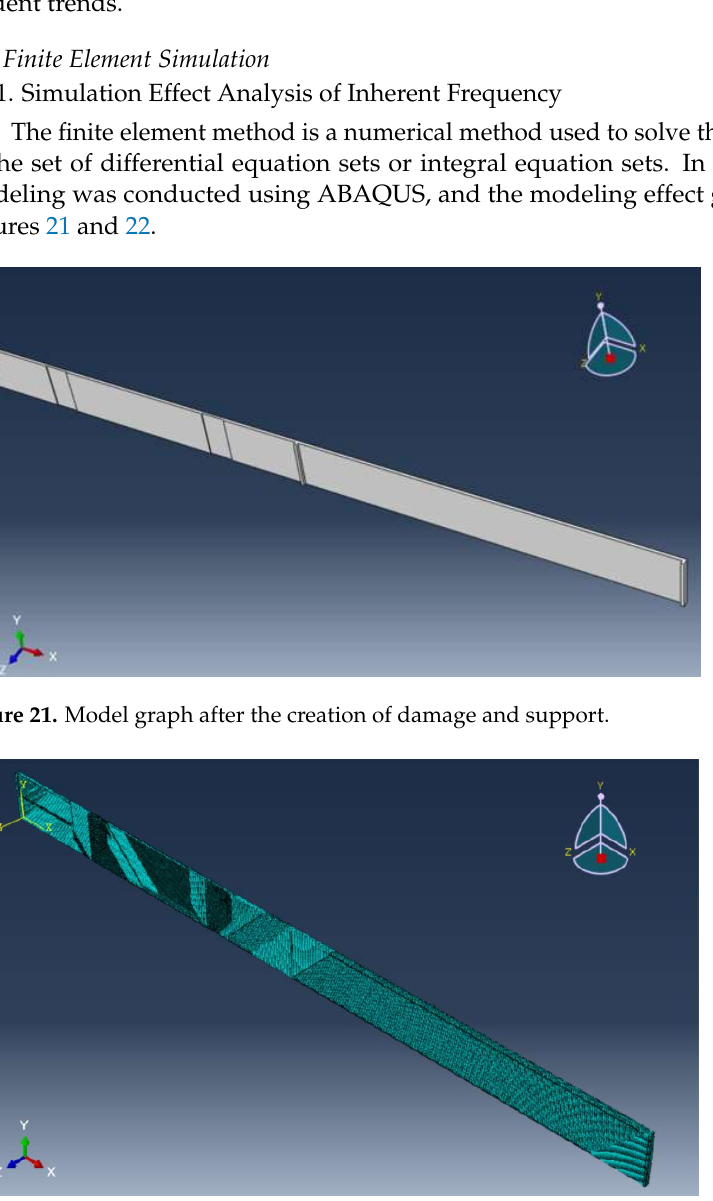
Figure 22. Model graph after the mesh generation.